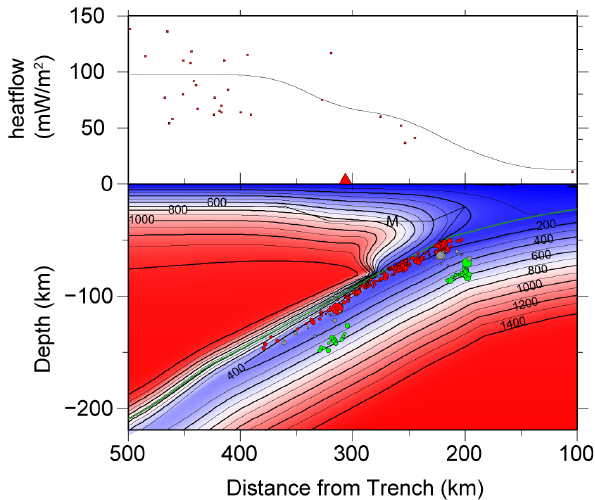
Fig. 4. Thermal model for cross section T18 over northern Tohoku. (Top:) Predicted heat flow (solid line) compared to observations (from Tanaka et al., 2004; plotted here due to the sparsity of the data from 100 km distance from the profile). (Bottom:) Temperature distribution. Temperature contours are in ◦ C. The top of the slab in this model is shown in green. Position of the volcanic arc is shown by the red triangle. The Moho is indicated by M. The seismicity within 10km on each side from this profile is shown in circles col- ored by distance to the slab surface to approximately indicate the upper plane (depths from 0–10km in red), and the lower plane of the double Wadati-Benioff zone ( > 25km depth in green). Scattered seismicity at a depth of 10–25km is shown in